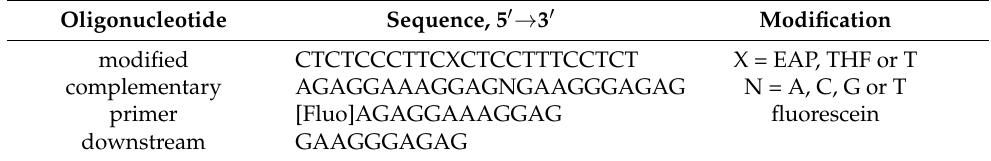
Table 3. Oligonucleotides used in this